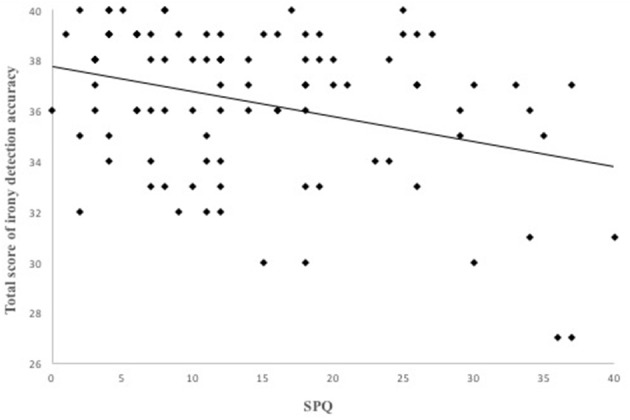
Schizotypal personality traits negatively predicted the total score of irony detection accuracy in tuerony in a linear regression.